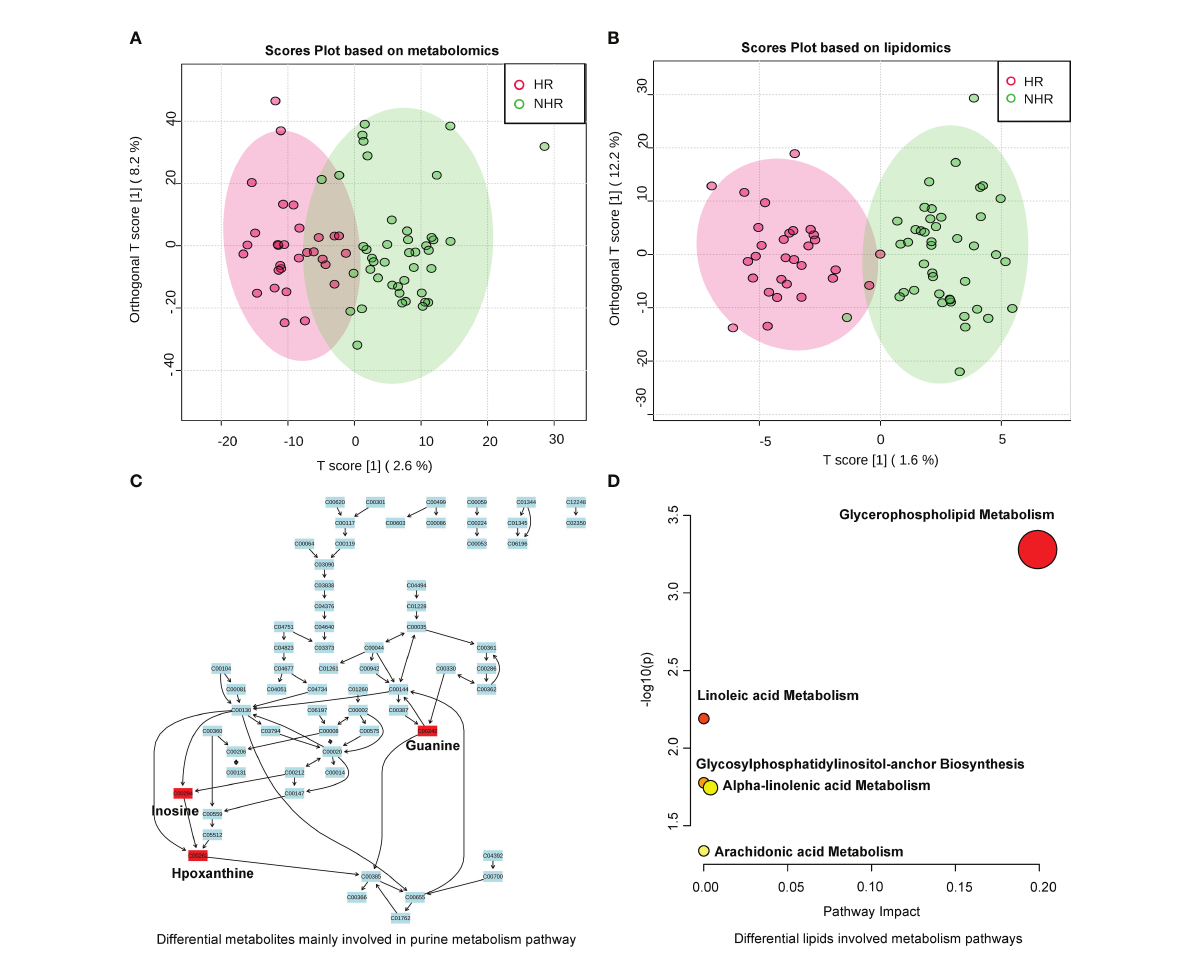
FIGURE 3 Results of metabolites pro fi les analysis between two groups. (A) OPLS-DA analysis displaying a discriminative trend of metabolite composition and (B) lipid composition between two groups. (C) Differential metabolites (screened by combining P value (<0.05) and fold change (>1.2)) mainly involved in purine metabolism (Hypoxanthine;Inosine;Guanine). (D) Differential lipid metabolite were phosphatidylcholines and phosphatidylethanolamines, which involved in glycerophospholipid, linoleic acid, alpha-linolenic acid, arachidonic acid metabolism, and glycosylphosphatidylinositol-anchor